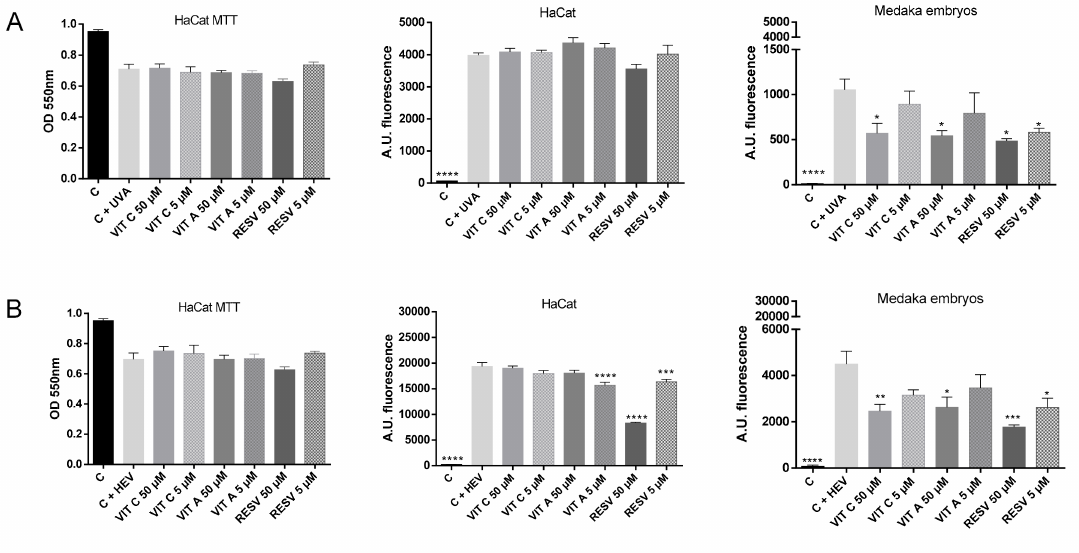
Figure 3. Barr graph showing ROS levels generated for HaCat culture cells and medaka embryos treated with three antioxidant compounds, after UVA radiation ( A ) and HEV radiation ( B ). VIT C—vitamin C, VIT A—vitamin A and RESV—resveratrol. * p < 0.05; ** p < 0.01; *** p < 0.001; **** p <